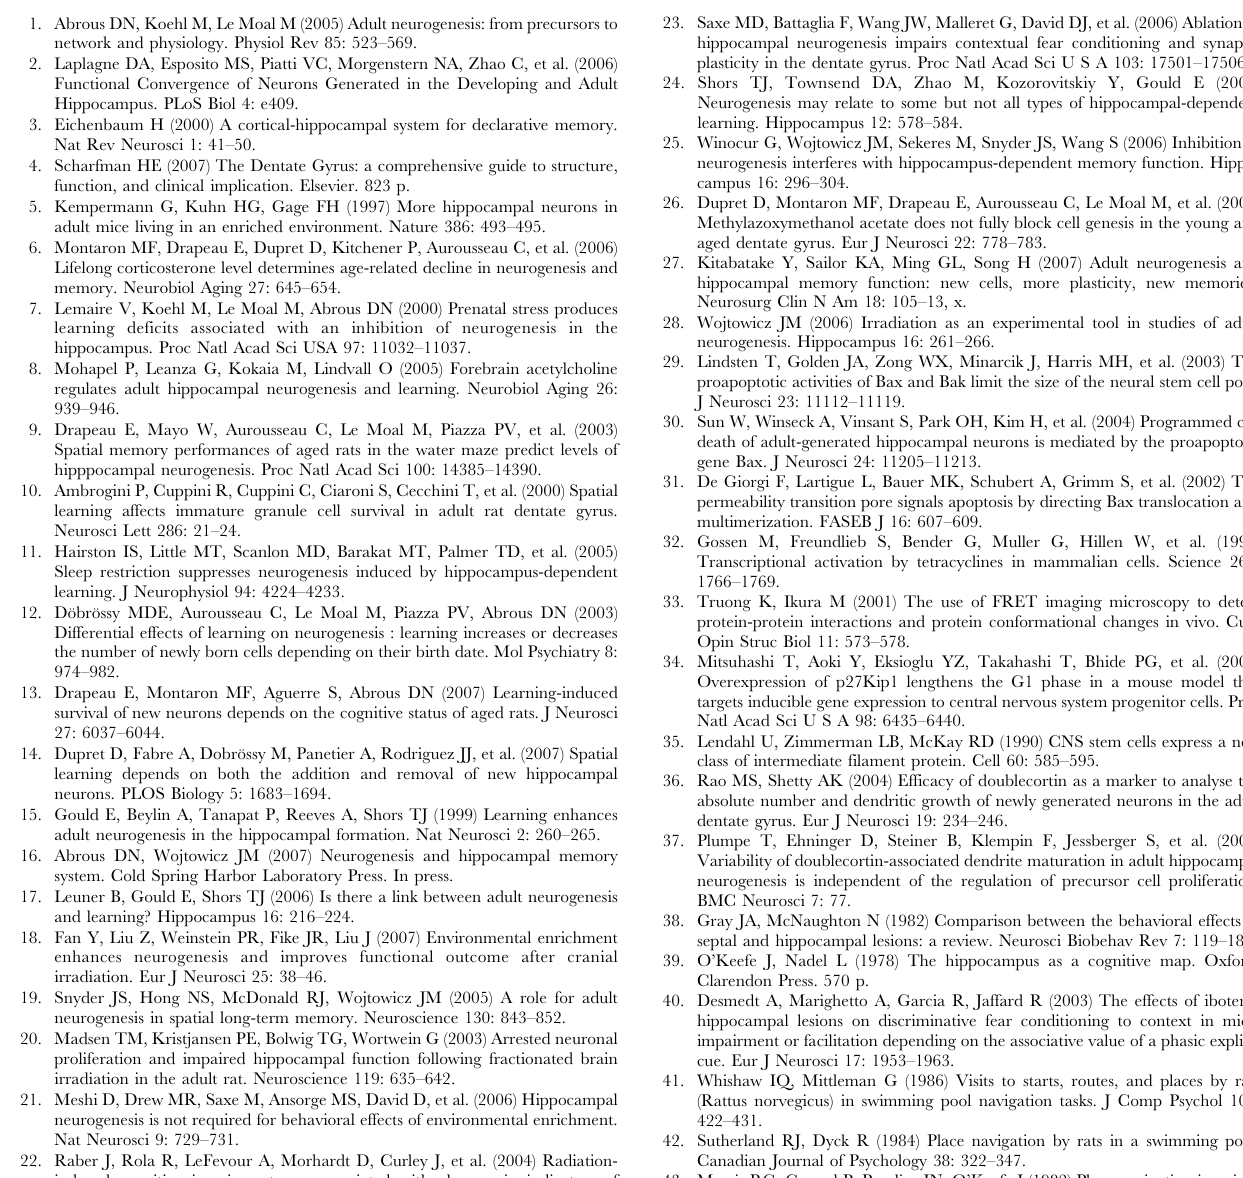
Table S4 Influence of adult hippocampal neurogenesis ablation on spatial navigation-related parameters. (A) The positive correlation between latency to reach the hidden platform and swim path length during the last training session using multiple start departure (Figure 6A, ‘‘V9’’) indicates that the behavioral deficit of bigenic-Dox mice does not rely on a non-cognitive strategy such as ‘‘passive floating’’. (B) The total swim path length and average swim speed during the probe test indicates that bigenic-Dox mice do not possess disrupted motor abilities. In addition, the estimation of the time spent swimming near the walls of the water maze indicates that bigenic-Dox mice are not inclined to use another non-cognitive swim strategy such as ‘‘thygmotaxis’’. (C) Latency, swim path and average speed to reach a visible platform during the cued test further indicate that the inability to locate a hidden platform of bigenic-Dox mice is not related to visual acuity deficits or altered general health